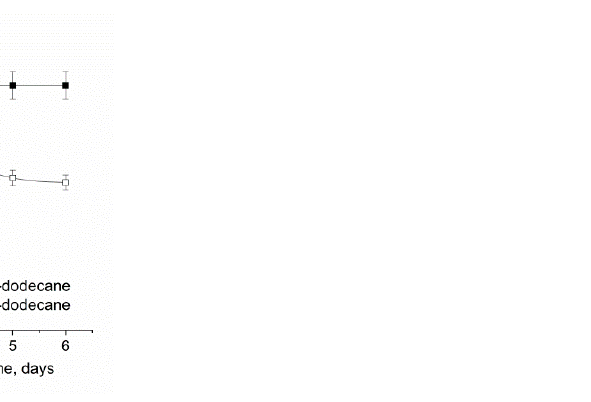
Figure 2. Comparison between the pellets’ size in absence and presence of n-dodecane.